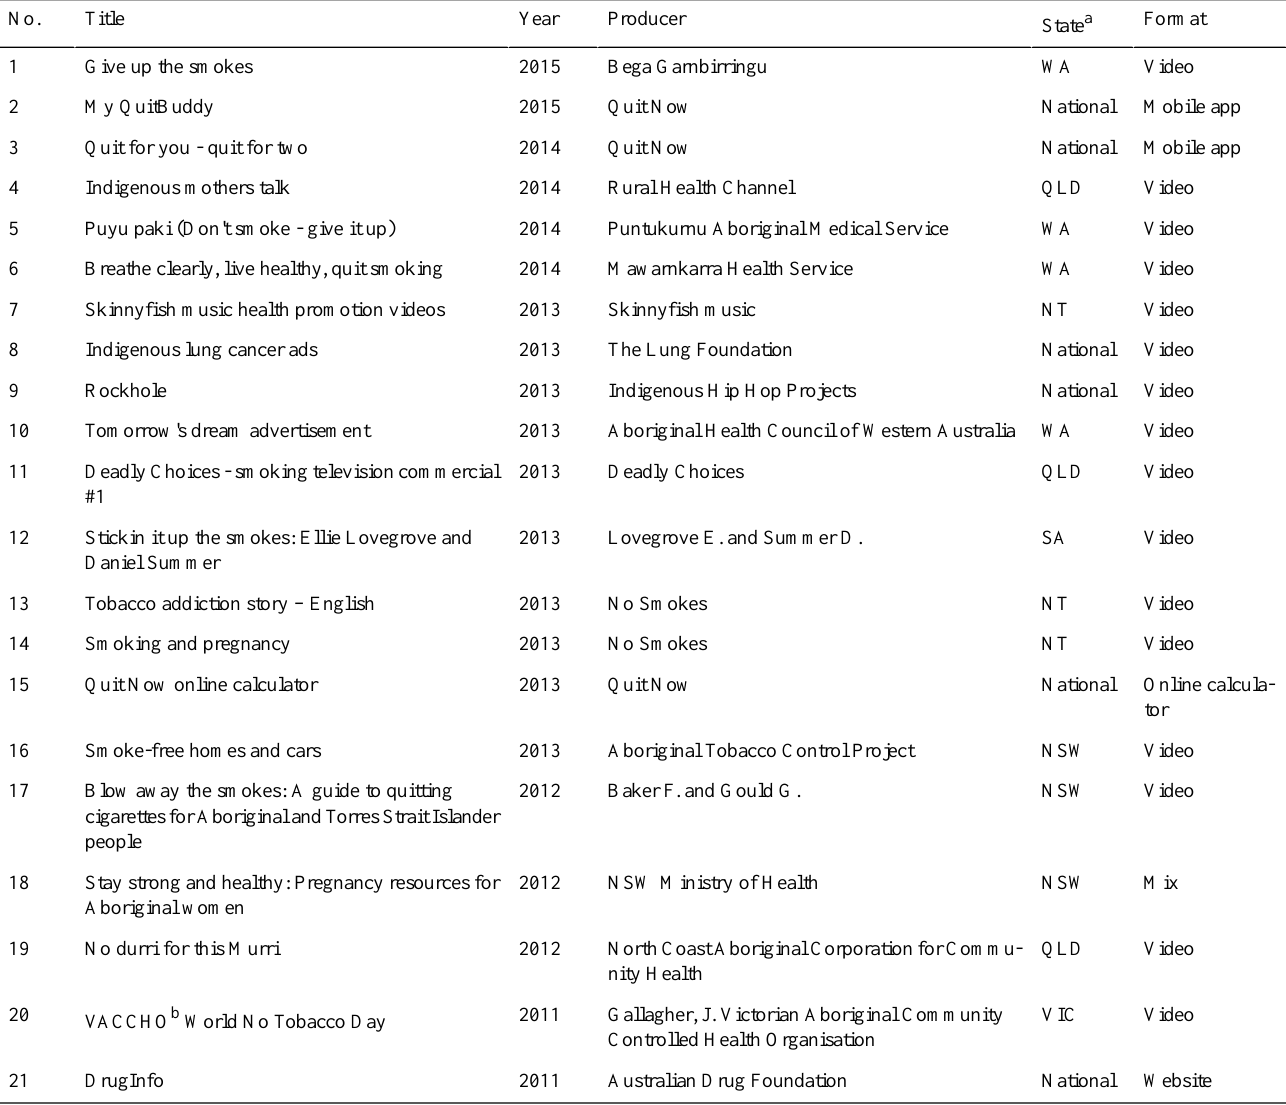
Table 2. Campaigns selected for further examination.